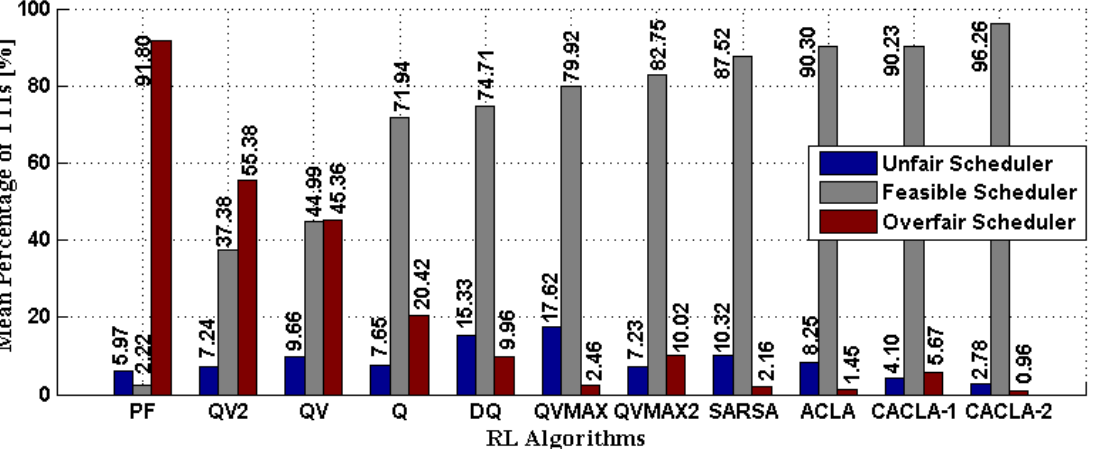
Figure 3. Next Generation of Mobile Networks (NGMN) fairness evaluation based on exponential moving